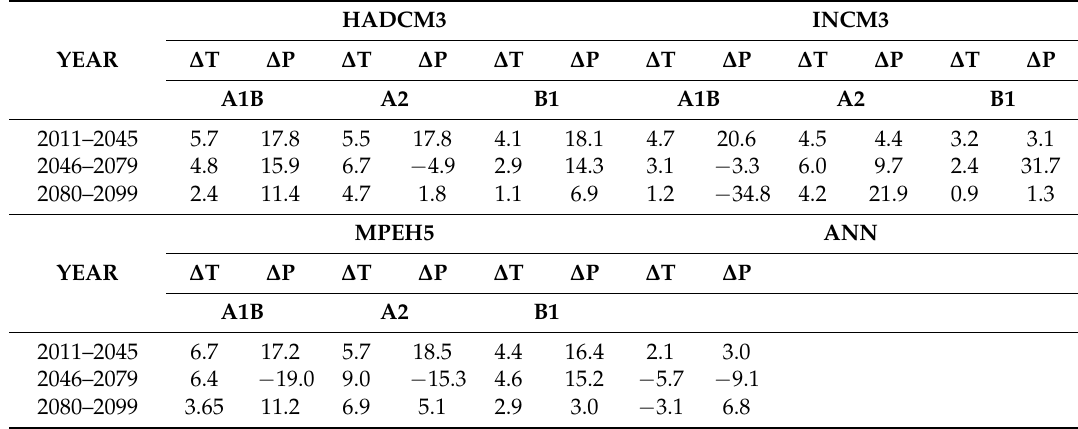
Table 2. Change in rainfall ( ∆ P) in percent and temperature ( ∆ T) in percent.